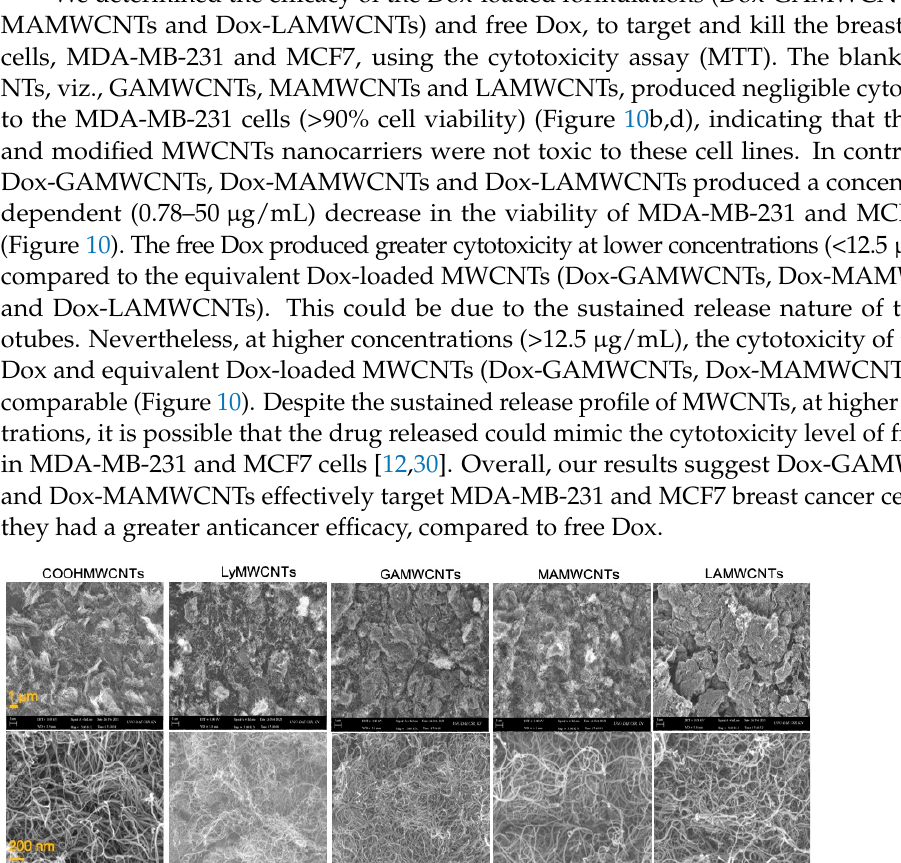
Table 3. Tabulated representation of the particle size, PDI and zeta potential of COOHMWCNTs, LyMWCNTs, Dox-GAMWCNTs, Dox-MAMWCNTs and Dox-LAMWCNTs (n = 3).